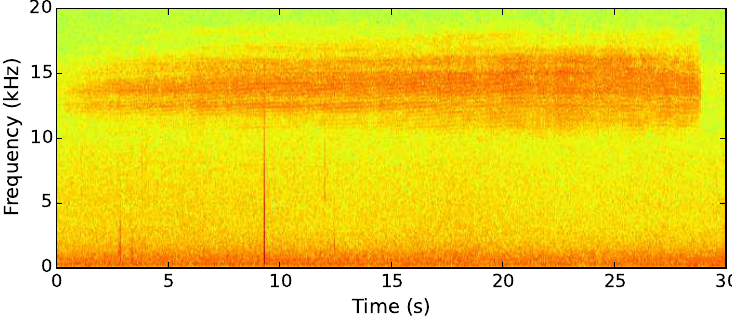
Figure 7. Spectrogram showing the second target sound—the song of the cicadetta